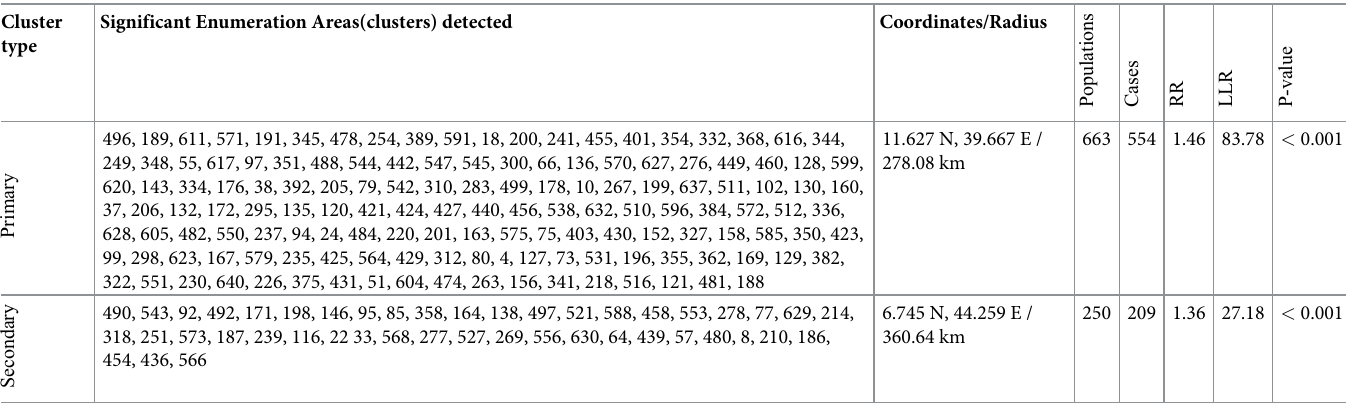
Table 3. Significant spatial scan statistics clusters of poor consumption of foods rich in vitamin A among children aged 6–23 months, EDHS, 2016. Cluster type